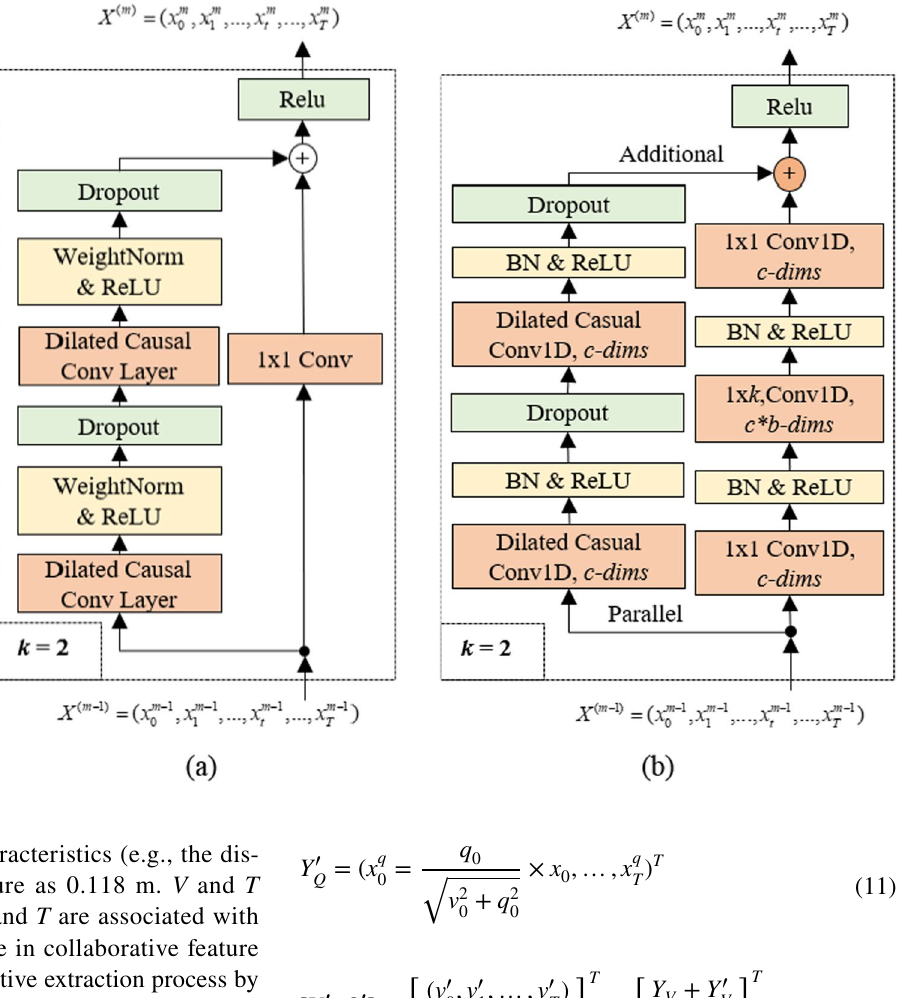
Fig. 3 The structure diagram of two residual blocks. a is the conventional residual block, b is the composited residual block (CRB) of the